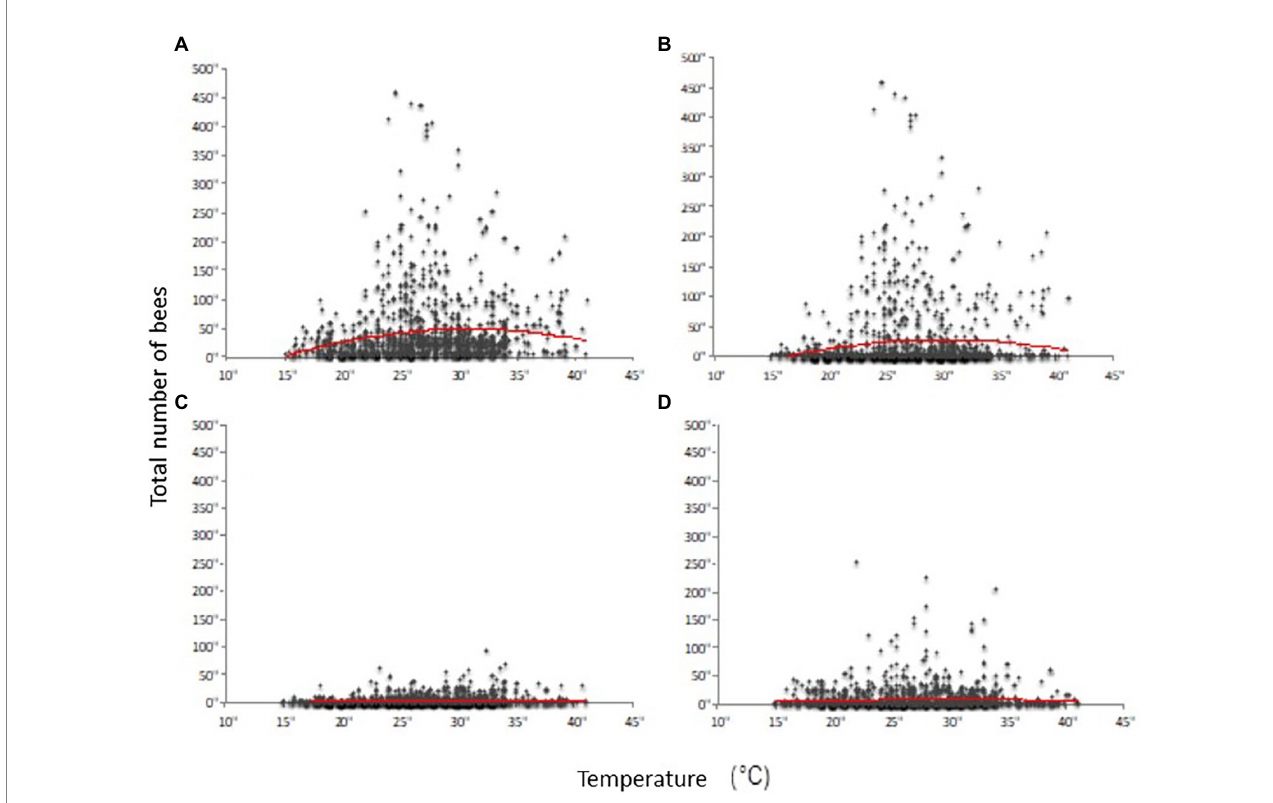
FIGURE 1 Abundance of bees on blooming plants as a function of ambient temperature. The x -axis is expressed in ° C. The graphs show the abundance of all bees (A) , managed bees (B) , bumble bees (C) and wild bees other than bumblebees (D) . The points illustrate abundance data and the red curve illustrates the result of the mathematical model linking abundance data to temperature (polynomial function; Rollin et al.,